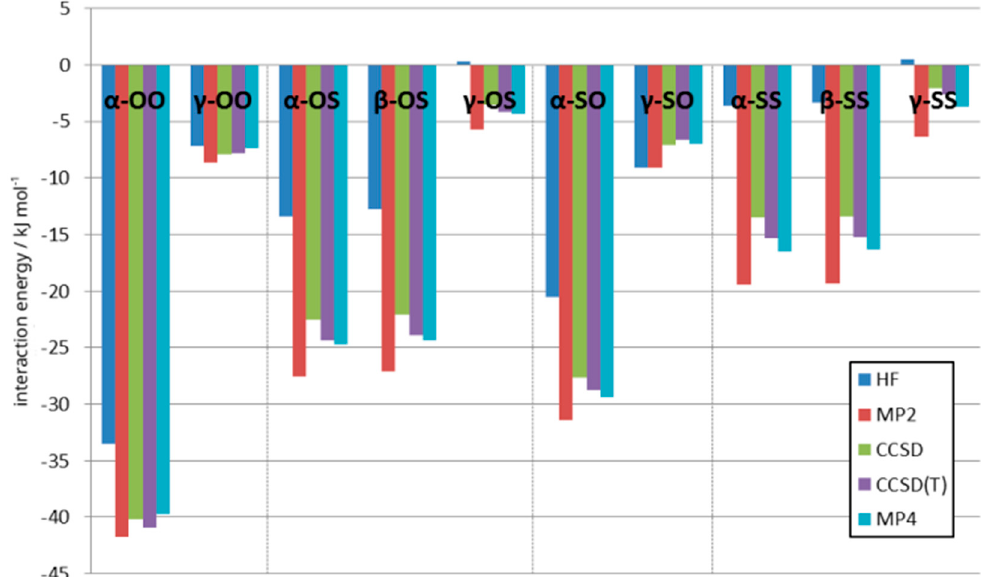
Figure 2. Bar graph illustrating the supermolecular interaction energies of the studied complexes obtained at different levels of theory. The energy values are given in kJ · mol − 1 .